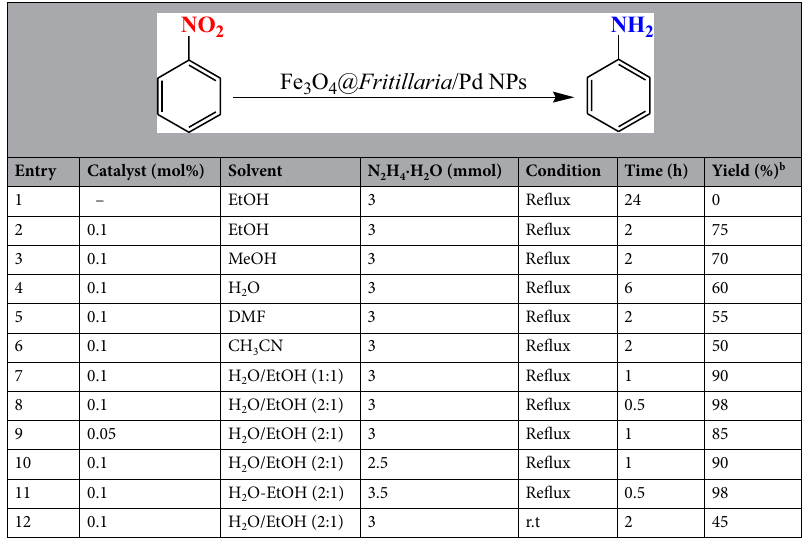
Table 1. Standardization of reaction conditions in the reduction of nitrobenzene over Fe 3 O 4 @ Fritillaria /Pd nanocomposite a . a Reaction conditions: nitrobenzene (1.0 mmol), solvent (3.0 mL), open air; ’ b Isolated yield.